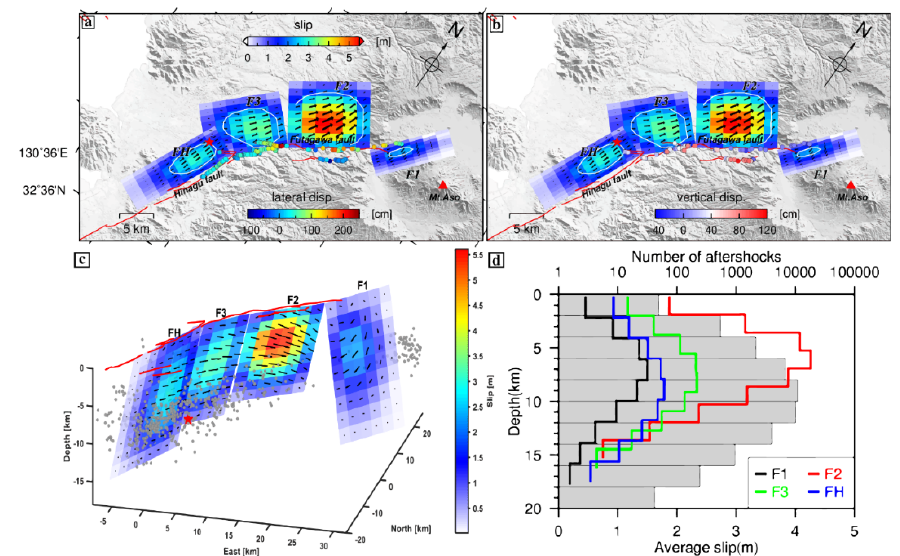
Figure 5. Slip distribution of the preferred model inverted from InSAR and GPS data, and comparison with surface ruptures and aftershocks. ( a–b ) Surface projection of the slip distribution. The color-filled circles in ( a ) show the lateral displacements of surface ruptures from the field investigation (positive values for right-lateral displacements), while those in ( b ) show the vertical displacements (positive values for south-side uplift displacements). The red star denotes the epicenter, and red lines show the active faults. The white contours highlight the asperities with a slip magnitude of over 2 m. Four segments are marked with F1, F2, F3, and FH from northeast to southwest. ( c ) 3-D slip distribution viewing from SSE. The black arrows show the slip directions of each sub-fault. ( d ) The slip averaged at di ff erent depths on each segment and number of aftershocks versus depth. Slips on four segments are plotted with curves. The gray histogram illustrates the depth distribution of